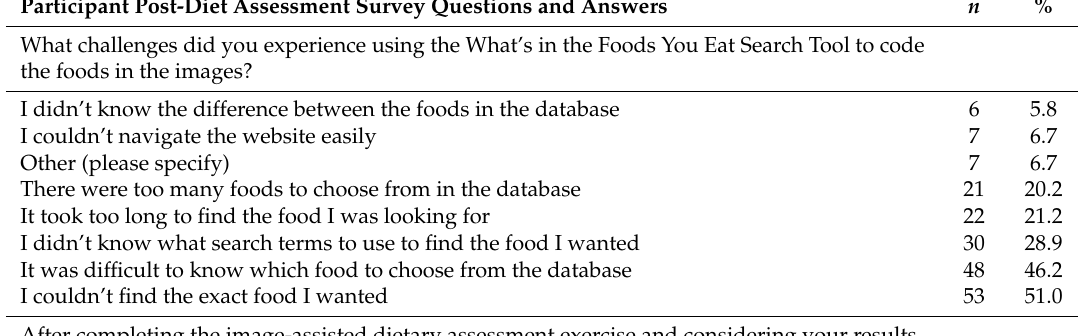
Table 3. Perceived challenges experienced by participants ( n = 104) in identifying foods from images using a database and estimating the serving sizes of foods in